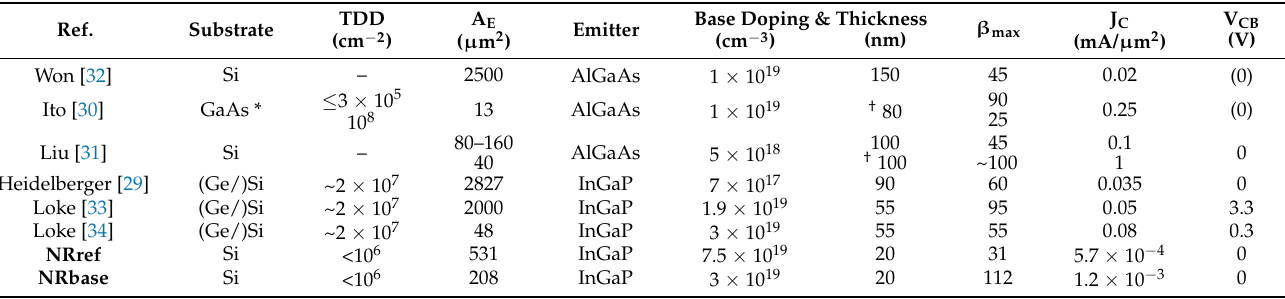
Table 2. Overview of HBTs with GaAs or compositionally graded (Al mole fraction increases from 0 to 0.10 or 0.12) AlGaAs base listing type of substrate, threading dislocation density (TDD), emitter area (A E ) and material, base doping and thickness, maximum DC current gain ( β max ), the collector current density (J C ) at which it is achieved and the collector-base bias (V CB ). GaAs substrates were having an intentional defect density as specified in the table.